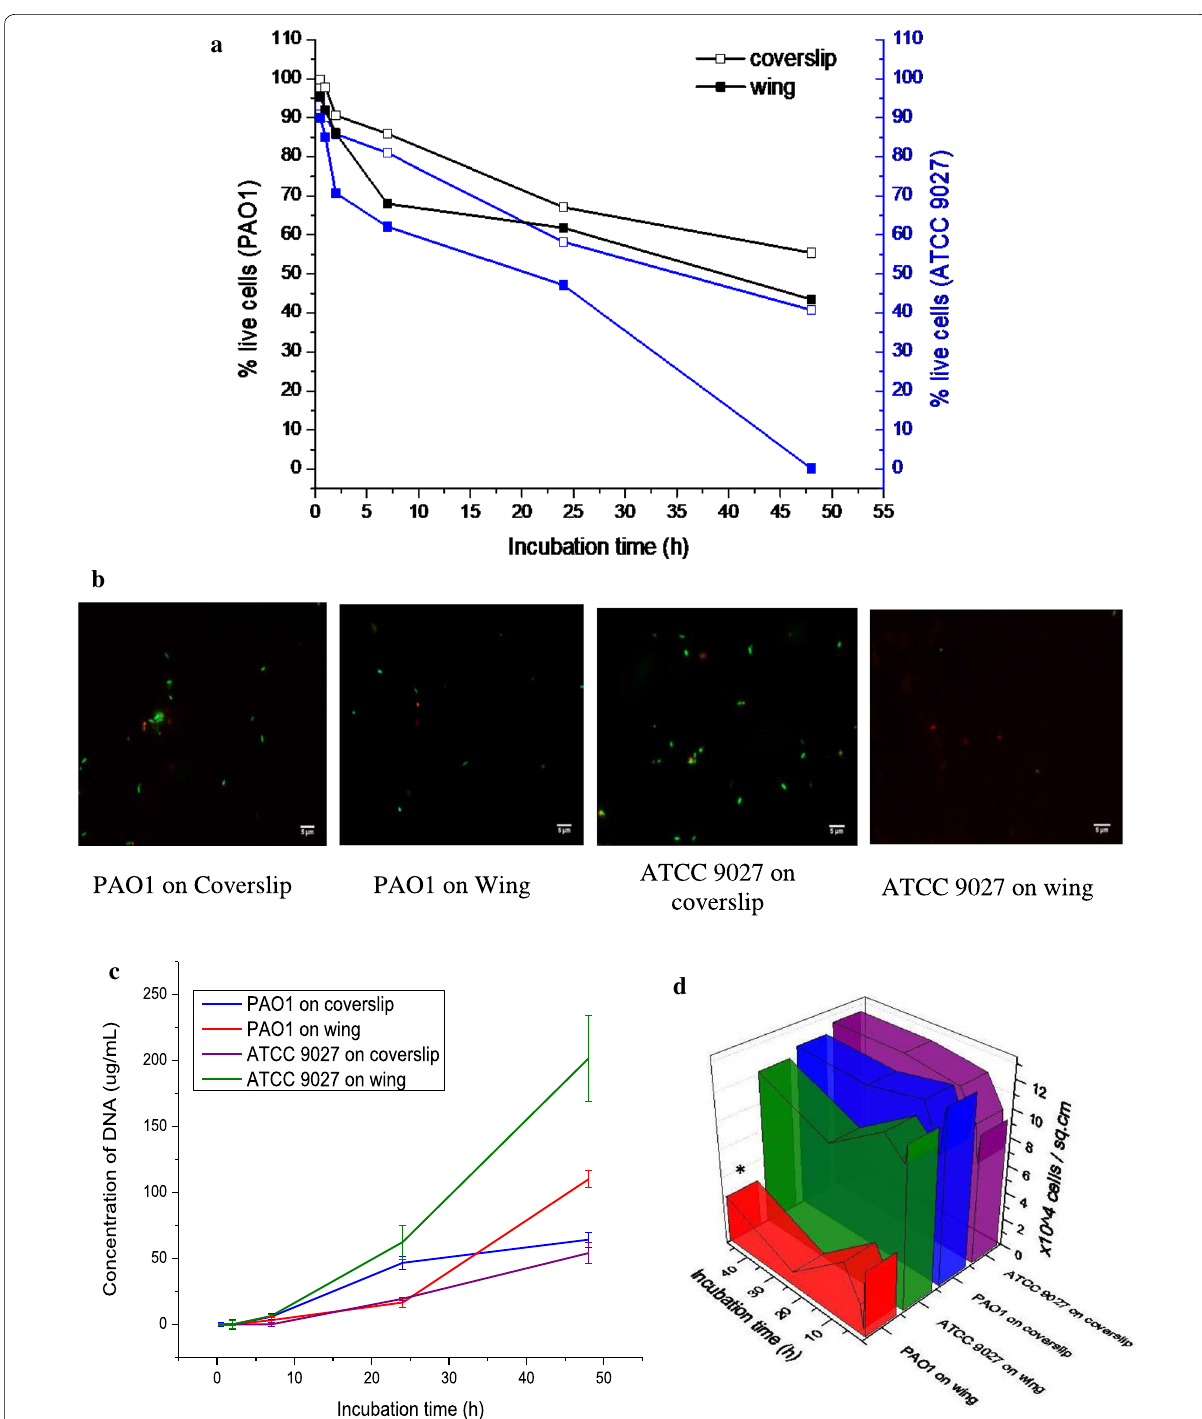
Fig. 2 a Quantitative viability analyses of P. aeruginosa ATCC 9027 and PAO1 on coverslip and wing using flow cytometer. b Fluorescent microscopic images of P. aeruginosa stained with SYTO9 and propidium iodide. Live cells appear green and, dead cells appear red. c Quantity of DNA in the P. aeruginosa suspension incubated with glass coverslip and dragonfly wings for discrete time intervals. d Number of P. aeruginosa cells attached to coverslip and wings enumerated using hemocytometer after incubation for 30 min through 48 h. *Represents statistical significance p < 0.05 using paired